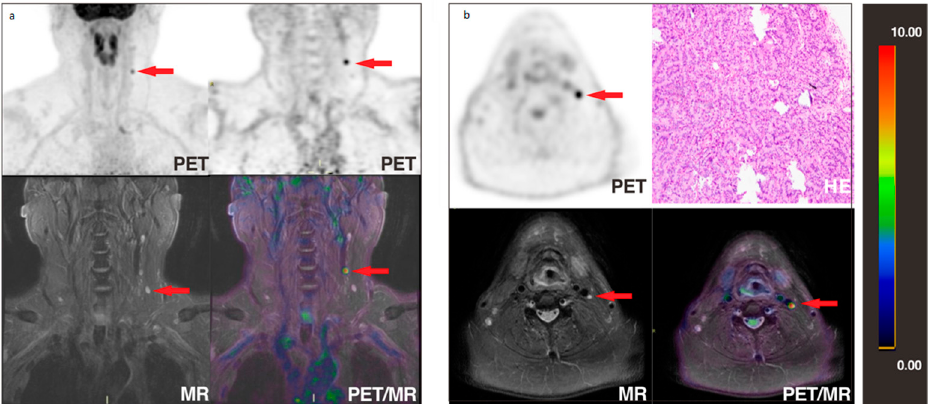
Figure 5. A 51-year-old DTC patient after comprehensive treatment presented with an unexplained increase in Tg (2.88 µ g/L). PET/MR depicted an increased uptake of a small lymph node (long diameter, 0.7 cm) in the left level III, with SUVmax 5.1, without other apparently abnormal lymph nodes (( a , b ), red arrows). 30 suspicious lymph nodes were removed by re-operation, and notably, only the lymph node identified on PET/MR was malignant.